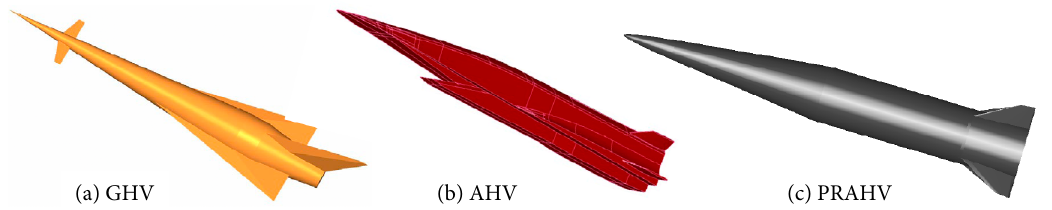
Figure 1. Configuration of two typical models and